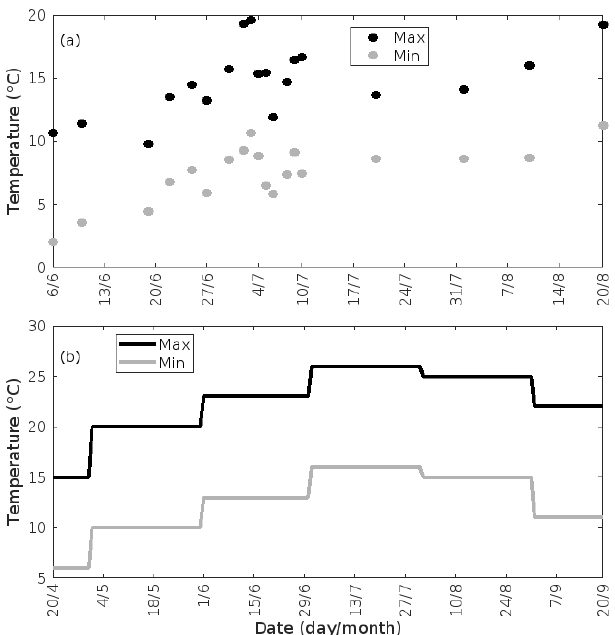
Figure 4. Daily maximum and minimum temperatures throughout the growing season at (a) SMEAR I, Lapland, and (b) southern Ger- many, used as default model input. Note the different time